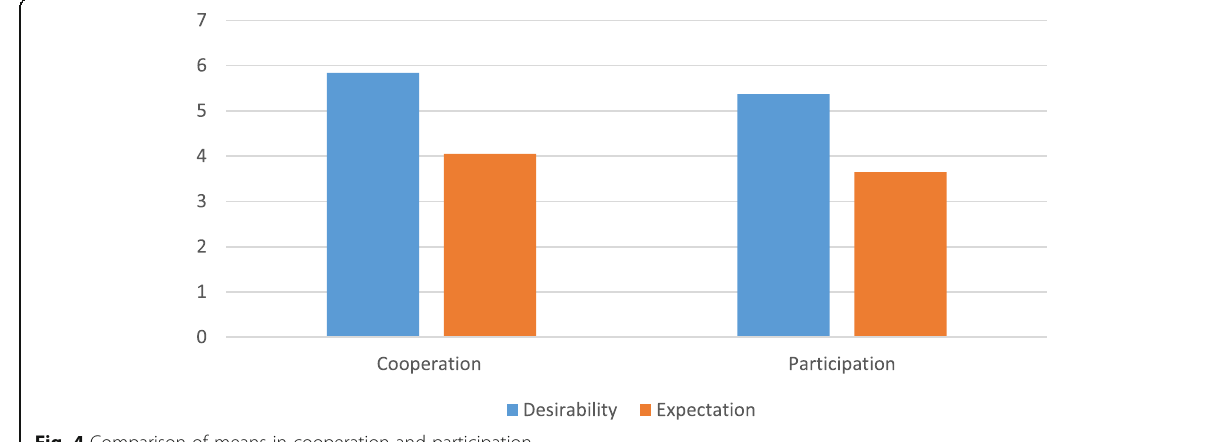
Fig. 4 Comparison of means in cooperation and participation